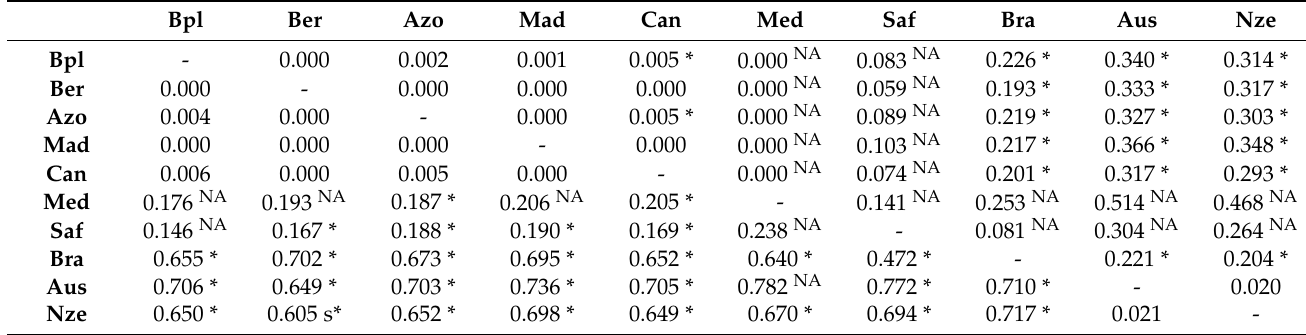
Table 5. Pairwise estimates of differentiation ( D EST , below diagonal) and fixation index ( F ST , above diagonal) between wreckfish samples (codes in Table 1). Significance of both estimates were corrected for multiple tests with the FDR algorithm of [55]; * p ≤ 0.001; NA, test not feasible due to the low number of genotyped specimens in samples Med and